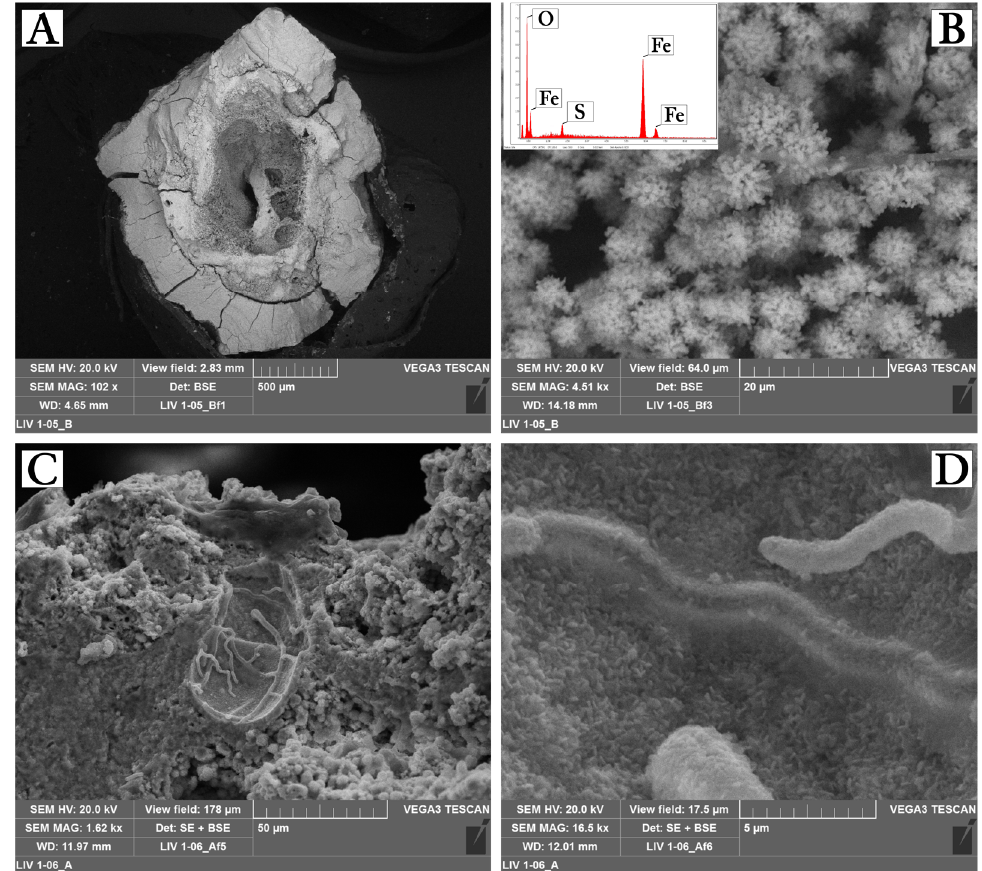
Figure 4. SEM image of a representative jelly stalactite. ( A ) General morphology showing the inter- nal feeding tube. ( B , C ) Images of the internal younger jelly part of the stalactite, with schwertmannite aggregates ( B ) and microbial structures ( C , D ).